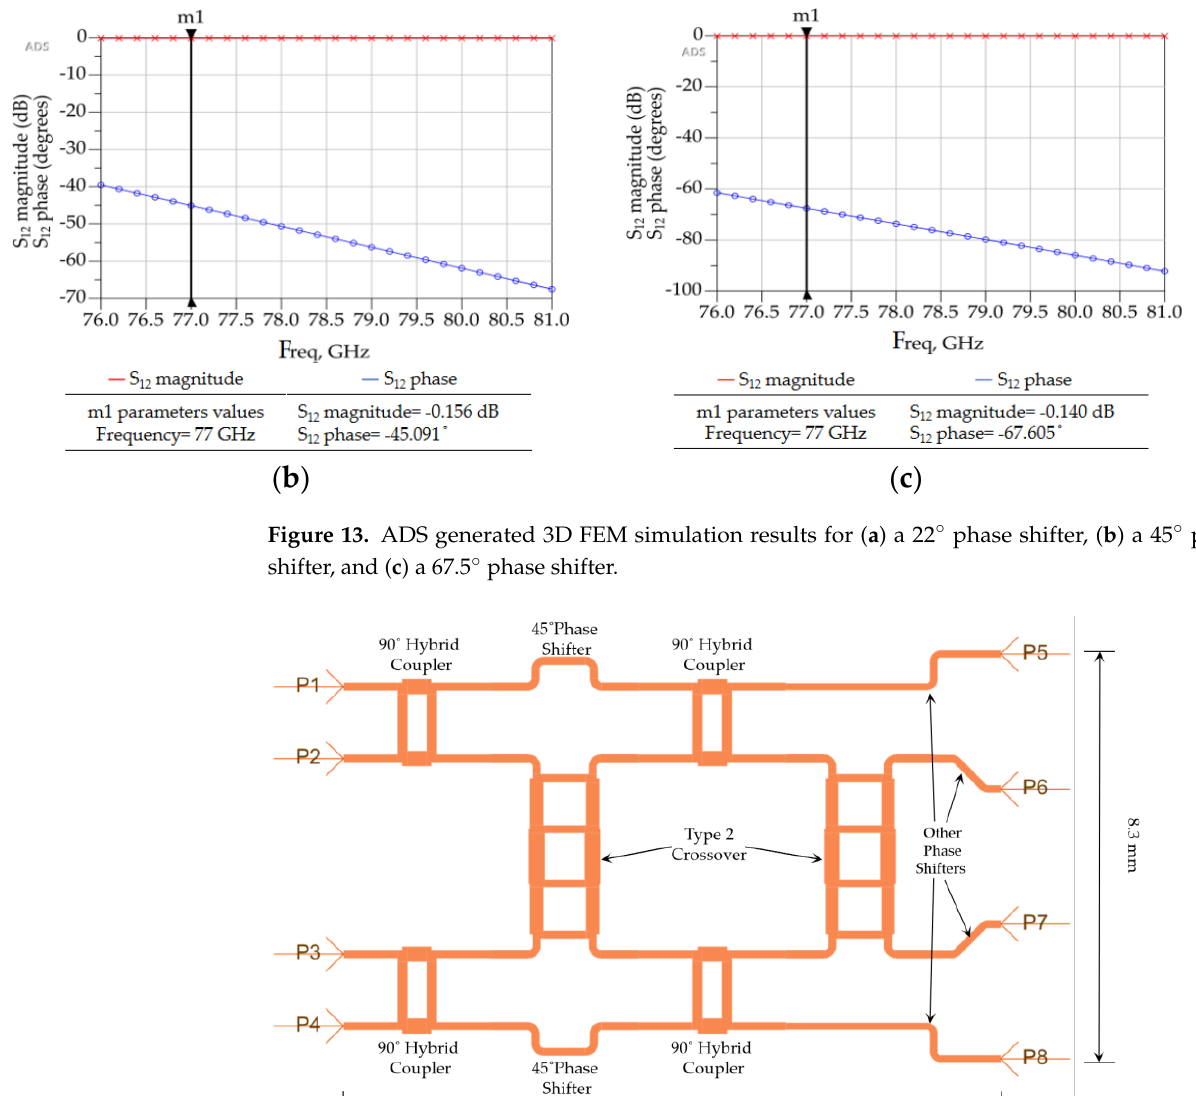
Sensors 2023 , 23 , x FOR PEER REVIEW 12 of 23